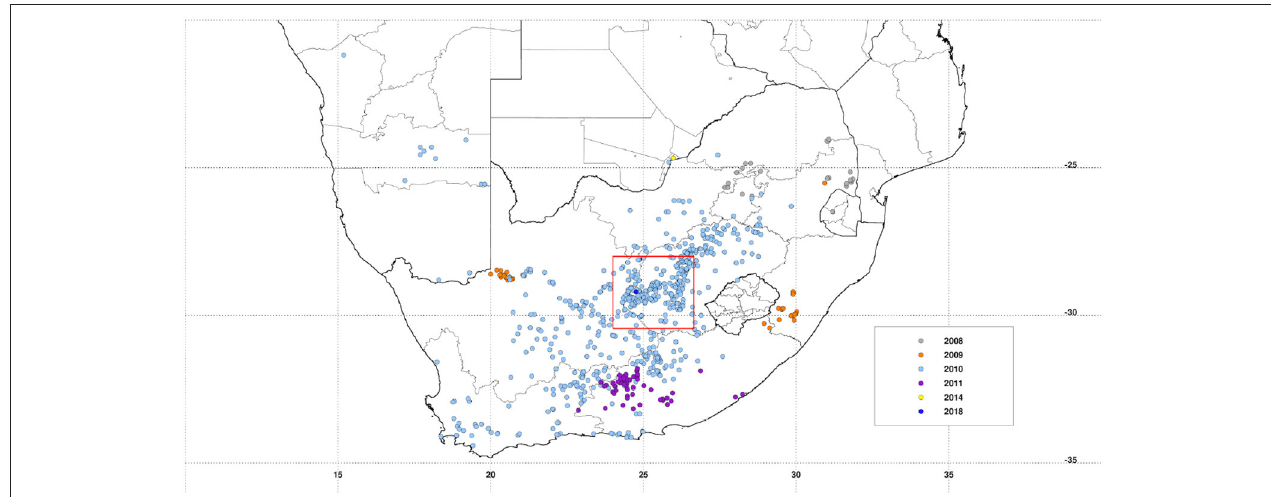
FIGURE 1 | Distribution of recent Rift Valley fever activity (2008–2018) over the southern Africa region. Rift Valley fever in the Republic of South Africa study region is marked by a red square outline [28S − 30.45S, 24E − 26.65E], centered on Free State and Northern Cape Province border, the epicenter of multiple epizootics. Data plotted were derived from the World Organization for Animal Health (OIE) World Animal Health Information System (WAHIS)